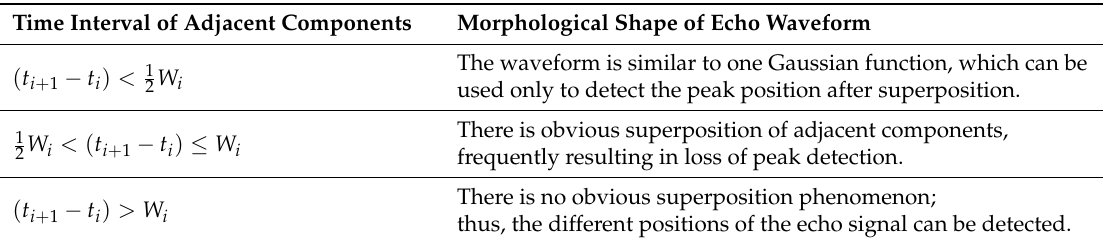
Table 1. Morphological characteristics and location of adjacent